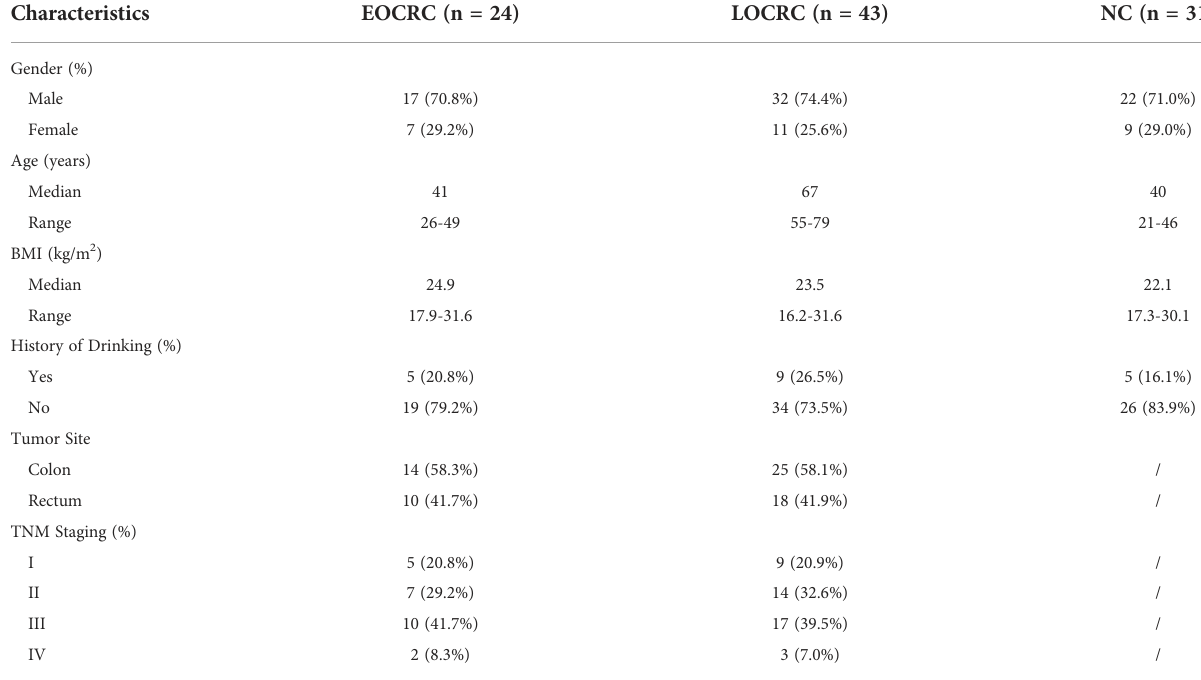
TABLE 1 Baseline information for three groups of